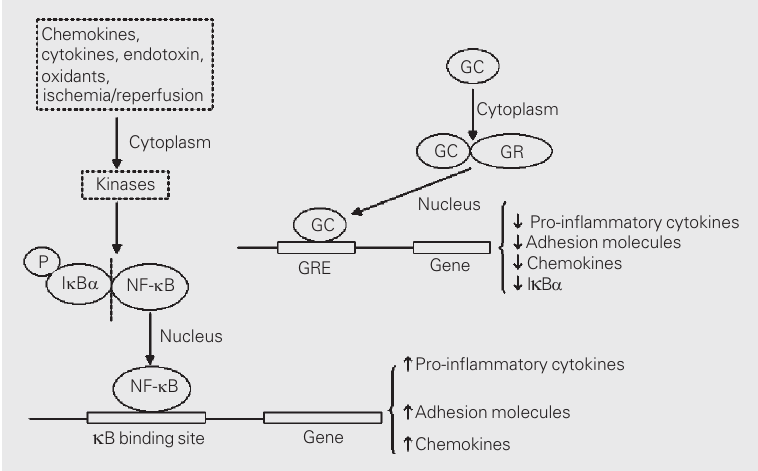
Figure 1. Mechanisms of action of corticosteroids. Glucocorticoids activate the cytoplas- mic glucocorticoid receptor, which translocates to the nucleus and serves as an important regulator of the proinflammatory process that is initiated through NF- κ B signaling. NF- κ B = nuclear factor- κ B; I κ B α = inhibitory protein of NF- κ B; GC = glucocorticoid; GR = glucocor- ticoid receptor; GRE = glucocorticoid response